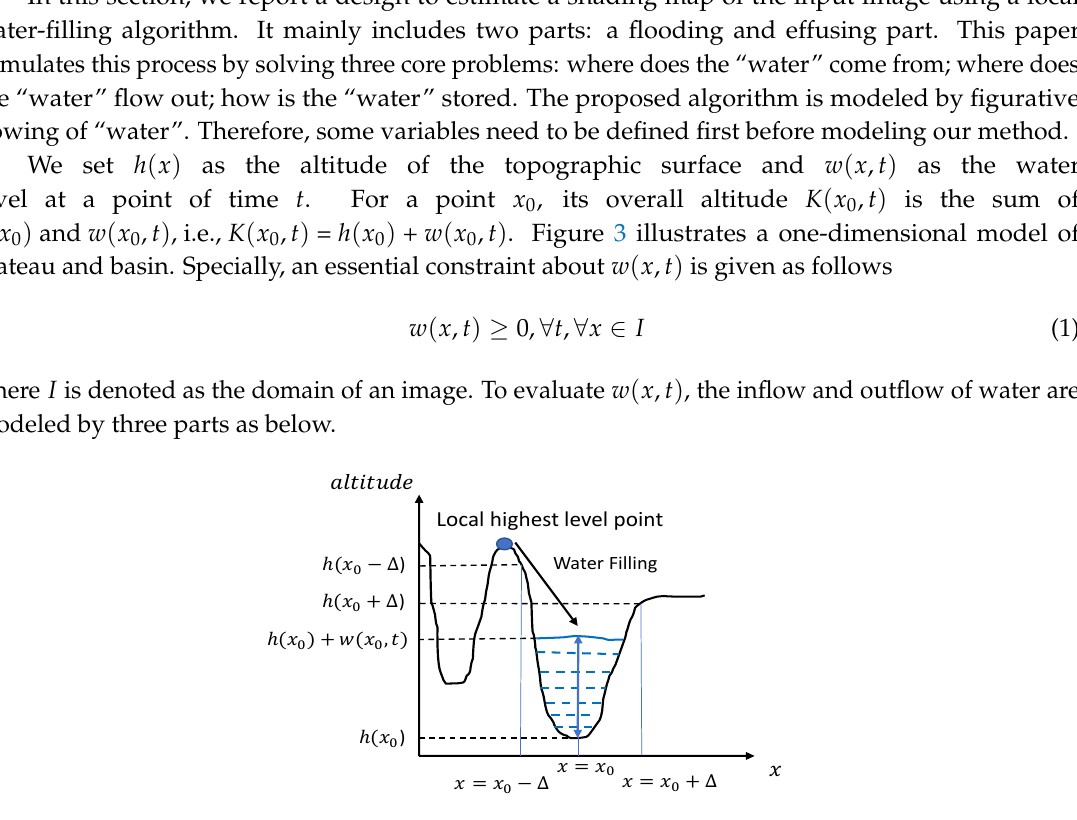
Figure 3. One-dimensional topographic model of a basin and its neighborhood, coupled with the water-filling